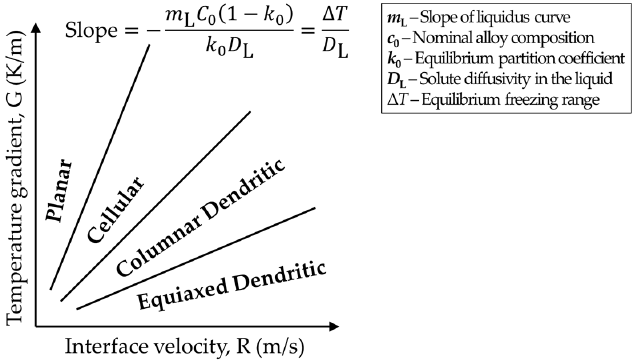
Figure 2. Schematic representation of the combined effect of thermal gradient and solidification velocity on solidification microstructure [14].